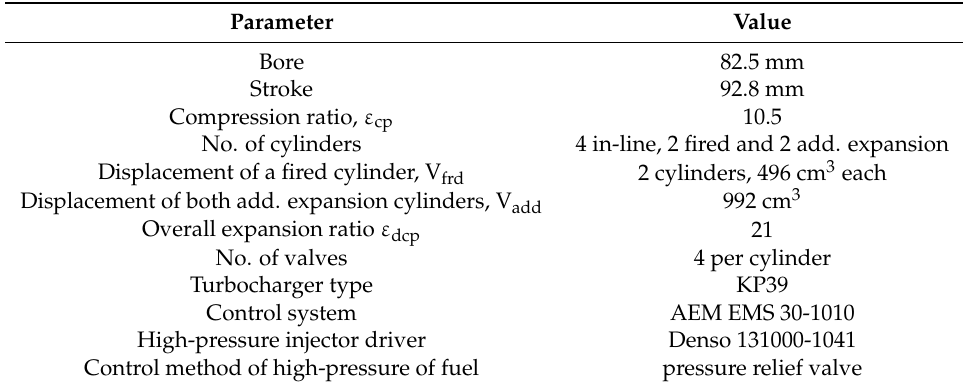
Table 1. Basic technical data of the test engine.